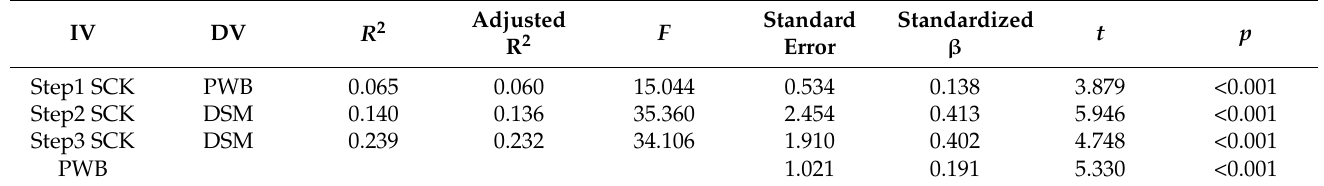
Table 4. Linear regression analysis of mediating effect of psychological well-being between self-care knowledge and disease self-management.